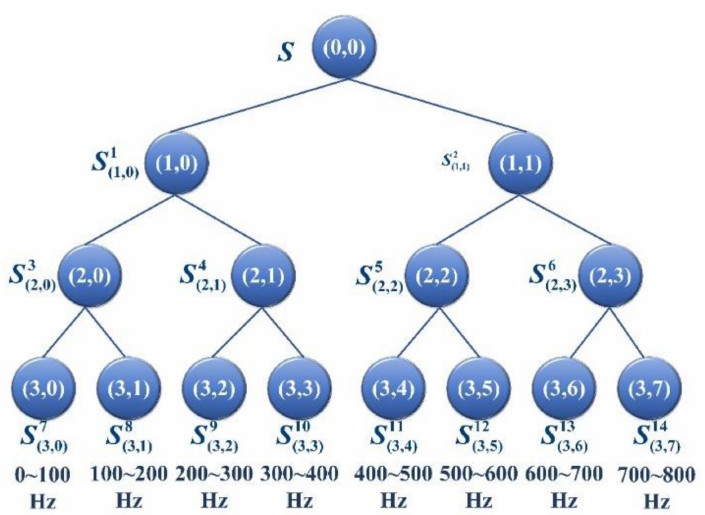
Figure 6. Schematic diagram of wavelet packet